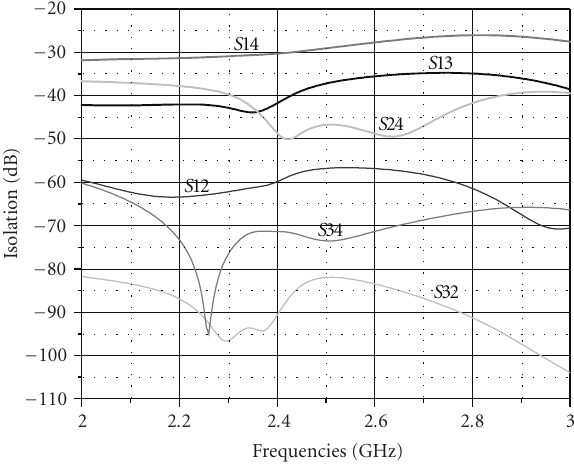
Figure 21: Isolation between antennas for the four-antenna